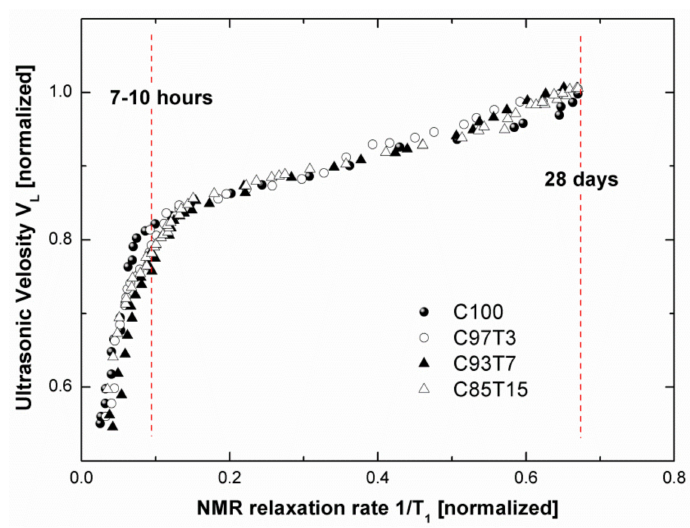
Figure 10. Correlation between ultrasonic longitudinal velocity and NMR relaxation rates. Both are normalized and the hydration times are taken as implicit parameters. Two distinct regions of linear correlations between V L and 1 / T 1 are observed from the starting time until ~7–10 h and ~7–10 h until 28